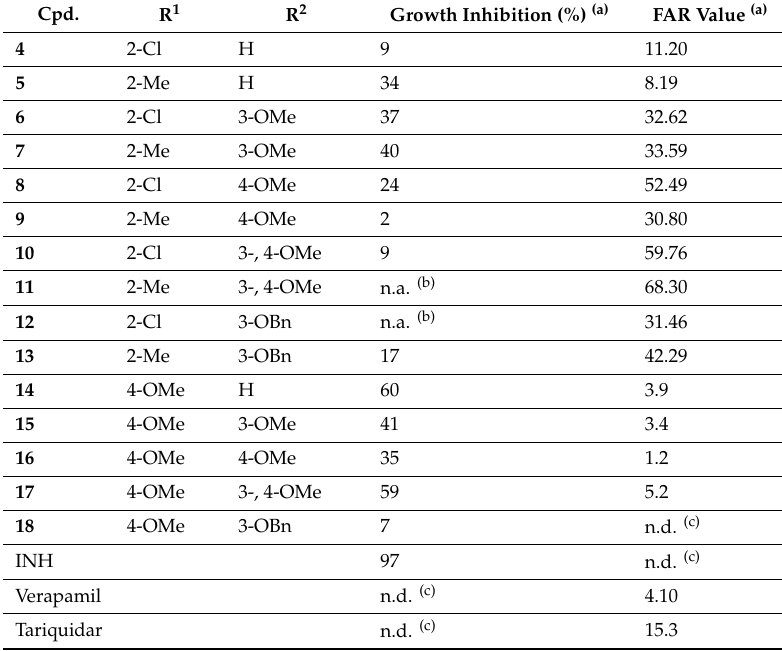
Table 1. Mycobacterium tuberculosis (Mtb) cell growth inhibition and ABCB1-inhibiting properties of target compounds 4 – 18 expressed as fluorescence activity ratio (FAR)